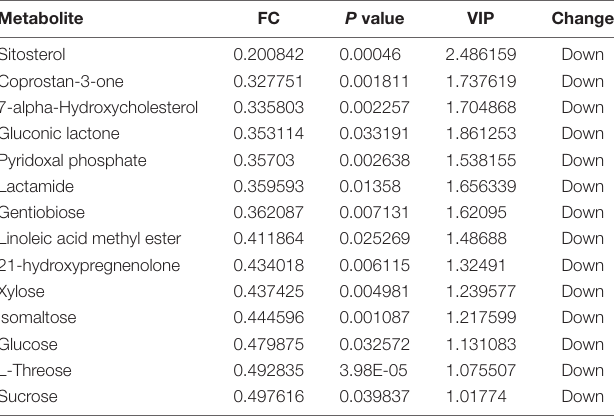
TABLE 3 | Metabolomic analysis of the sugar beet root exudates in T5 compared to T3. Metabolite